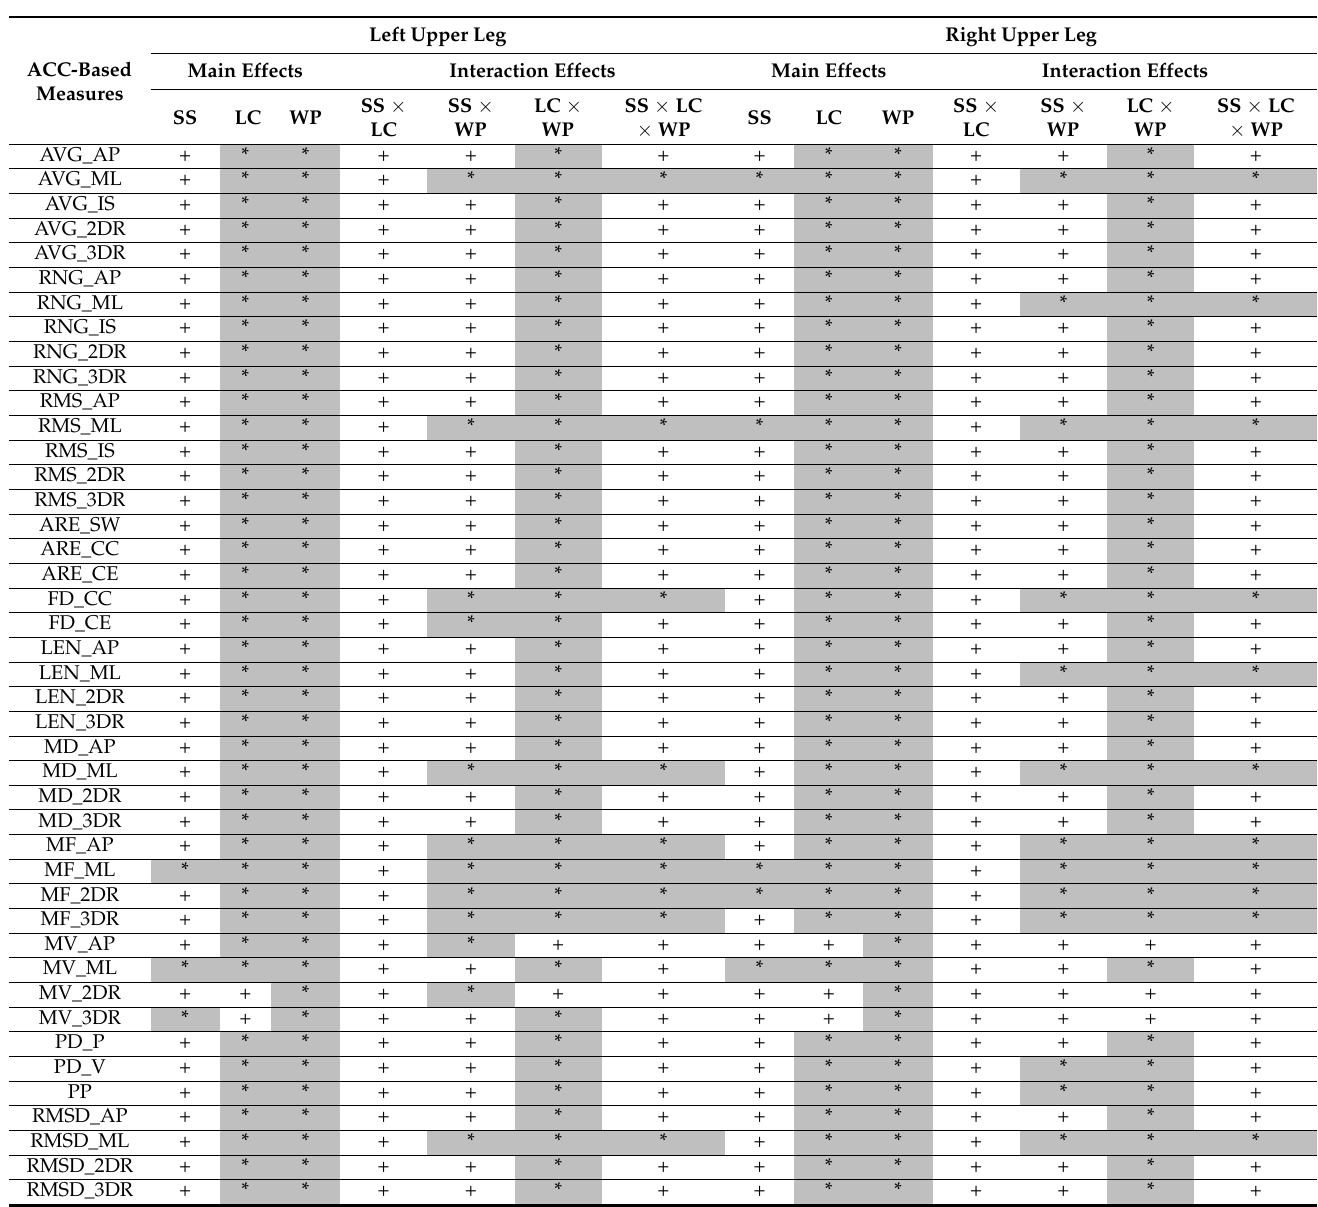
Table A3. Results 1 of t -tests and Analysis of variance using the acceleration data of Upper